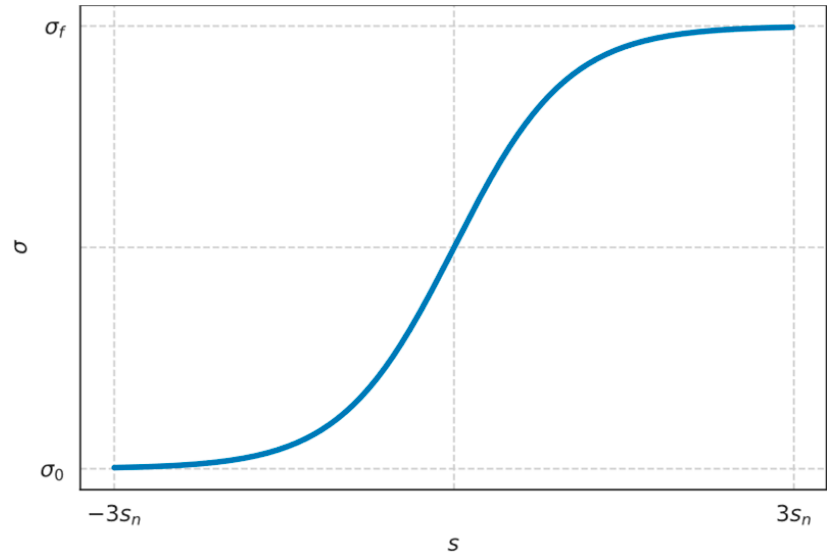
Figure 3. Curricula training scheduler curve.